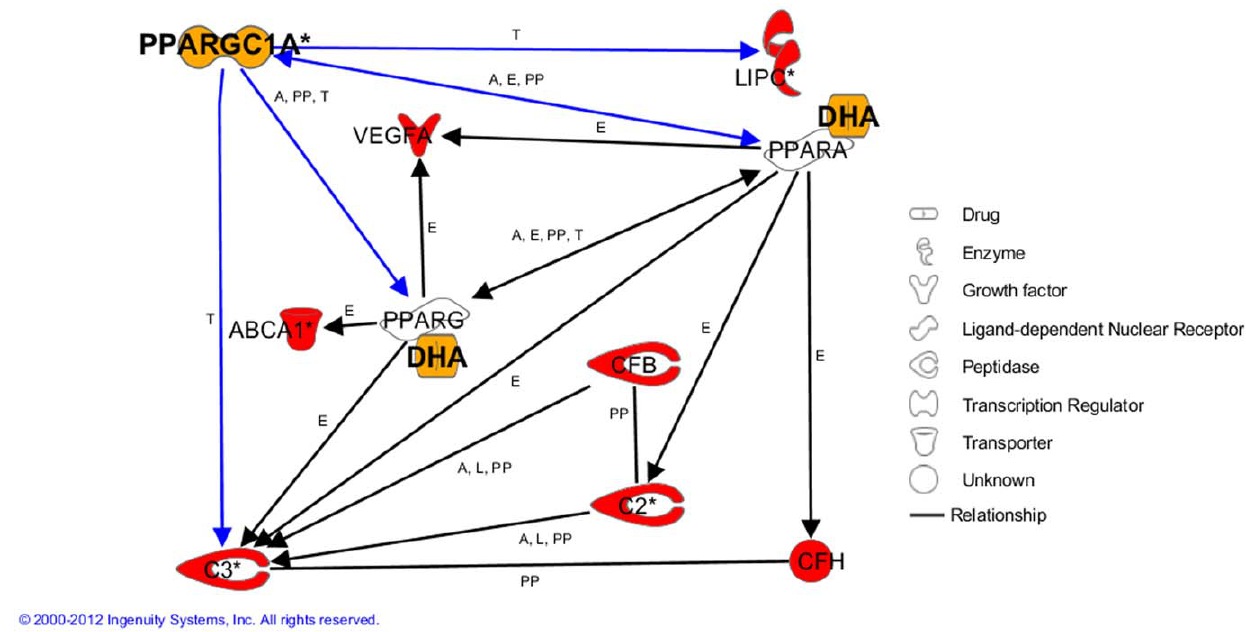
Figure 1. Relationships of PPARG co-activator 1 alpha (PPARGC1A) with AMD-associated genes or their products. Genes associated with AMD in extant studies are shaded in red. DHA=docosahexaenoic acid (a PPAR agonist). Diagram was generated with Ingenuity Pathway Analysis H software. Full names for genes represented by symbols exist at http://www.ncbi.nlm.nih.gov/gene/. Direct effects of PPARGC1A are represented by blue arrows. Letters on the arrows represent the nature of evidence and are defined as follows: A=activation, E=expression, L=proteolysis, PP=protein-protein interaction, T=transcription.